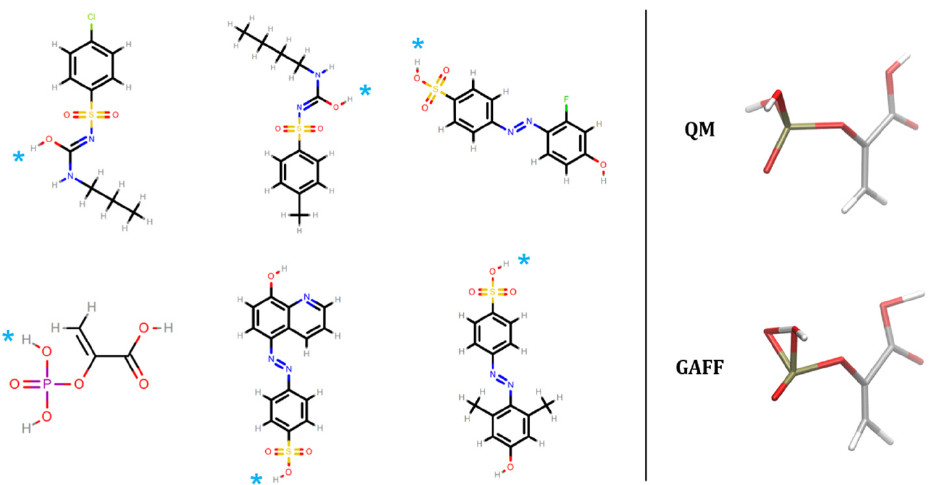
Figure 2. Molecules with extreme relative conformer energies for GAFF. The right hand side depicts the QM and FF geometries for phosphoenolpyruvic acid. The GAFF structure shows a representative overlap of a polar hydrogen atom with its connected parent atom due to a missing van der Waals parameter. On the left hand side, the overlapping hydrogen for the six molecules are denoted by cyan asterisks.